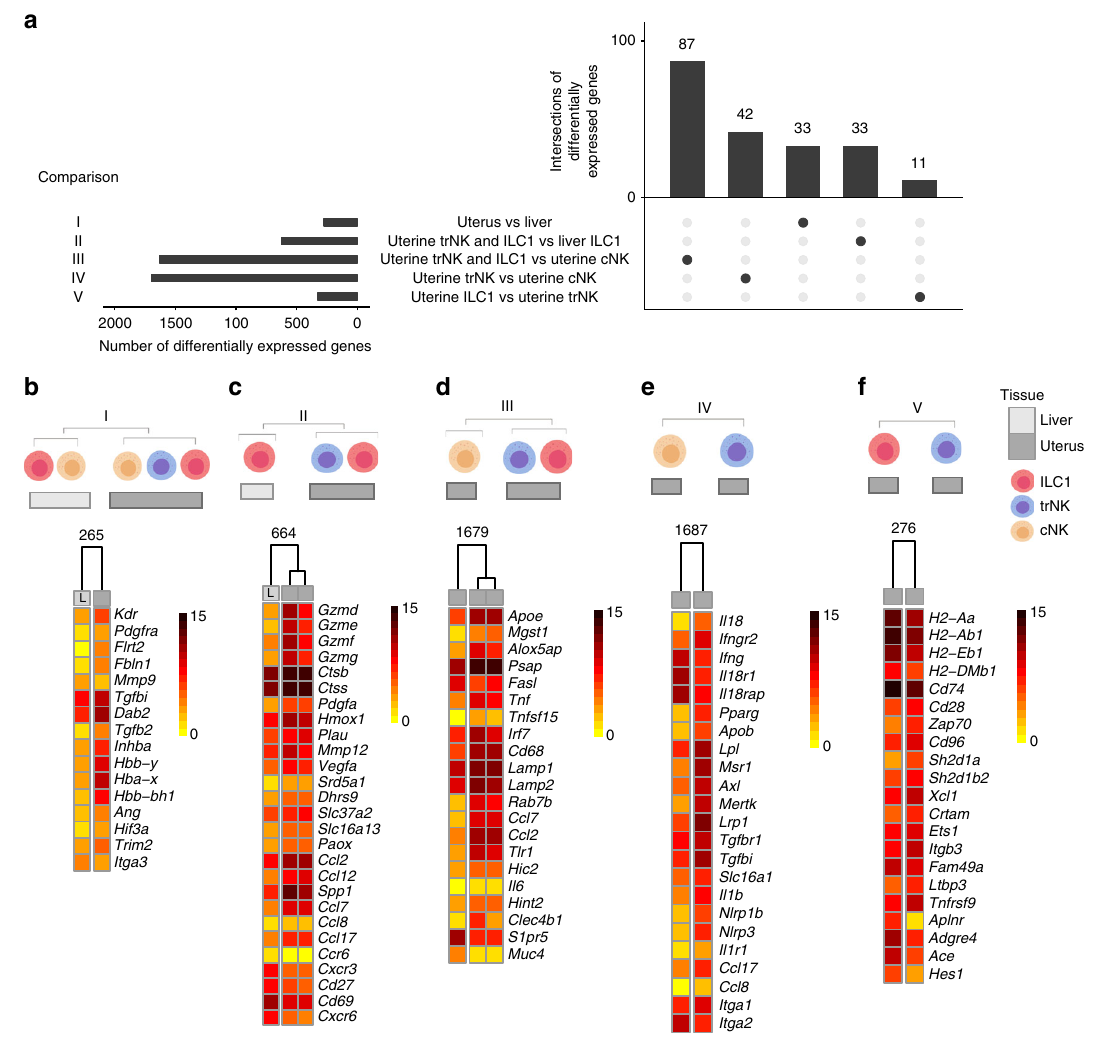
Fig. 3 Core gene signatures of uterine g1 ILCs. a UpSetR plot displaying 5 comparisons of g1 ILCs in uterus and liver. b – f Heat maps showing selected genes for comparisons I – V in a . Selected genes were chosen from a total list of differentially expressed genes as some representative genes from enriched pathways shown in Supplementary Figure 3A-E as well as from UpSetR lists of intersections of differentially expressed genes. Numbers above heat maps indicate a total number of genes in a corresponding list of differentially expressed genes in that comparison: b comparison I: all uterine g1 ILCs vs all liver g1 ILCs. Selected genes were chosen from enriched pathways in Supplementary Figure 3A; c comparison II: uterine ILC1s and trNK vs liver ILC1s. Selected genes were chosen from enriched pathways shown in Supplementary Figure 3B; d comparison III: uterine ILC1s and trNK vs uterine cNK cells. Selected genes were chosen from enriched pathways shown in Supplementary Figure 3C; e comparison IV: uterine trNK vs cNK cells. Selected genes were chosen from enriched pathways shown in Supplementary Figure 3D; f comparison V: uterine ILC1s vs trNK cells. Selected genes were chosen from